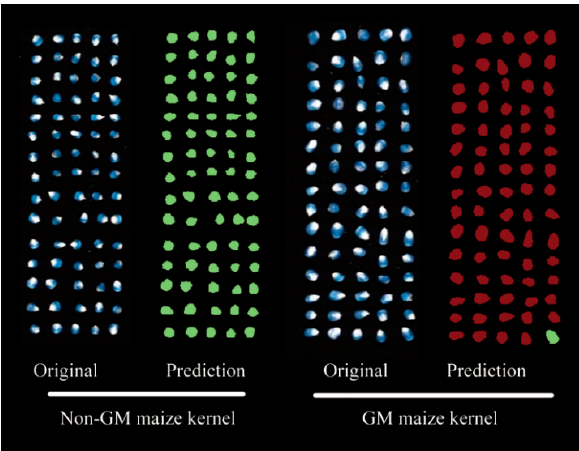
Figure 8. Visualization of independent maize kernels by the SVM classification process using optimal wavelengths in the hyperspectral images. Green denotes non-GM maize kernels, and red identifies GM maize kernels.